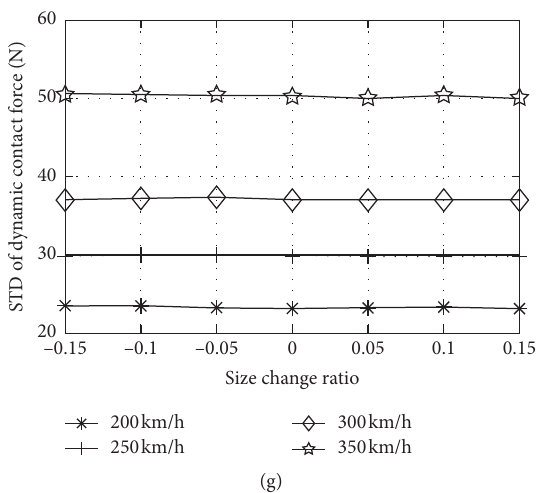
− 15%); (b) variation of L 1 (failed at 2 ; (c) variation of L 4 (failed at 10% and